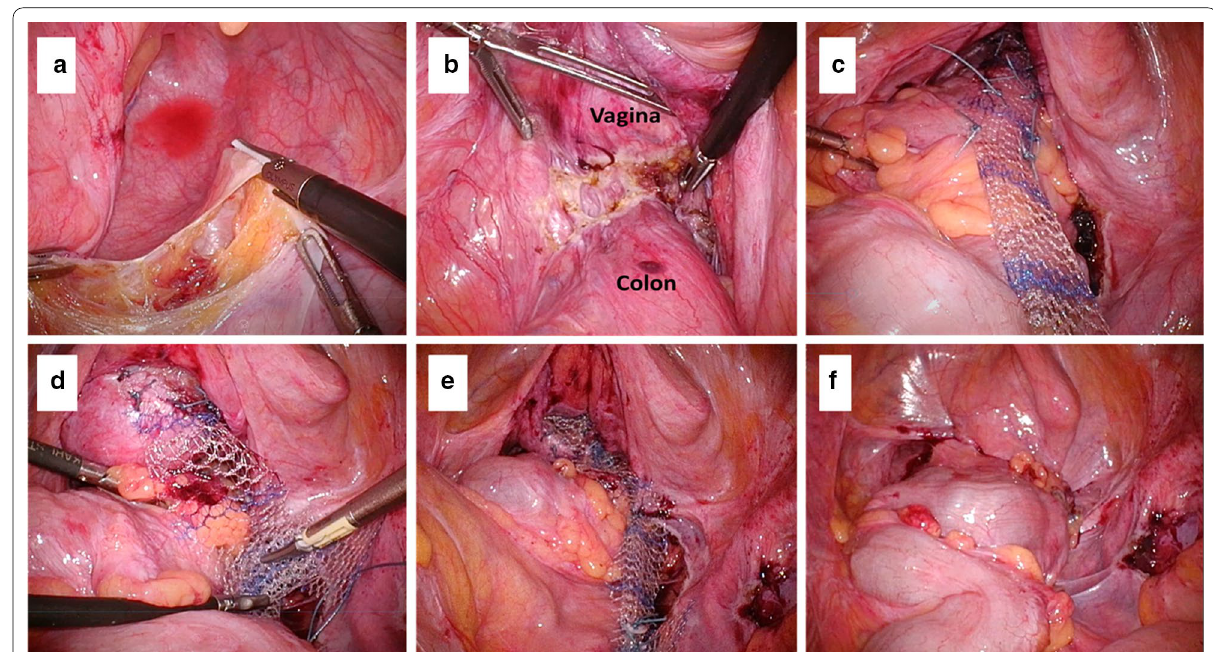
Fig. 3 Intra-operative findings. a The peritoneum was dissected from the right pelvic wall. Scar and a suture on previous laparoscopic posterior mesh rectopexy were observed (arrow). b The rectovaginal space was destroyed in the previous surgery. c The self-cut mesh was fixed with non-absorbable suture on the large colon. d The self-cut mesh was fixed at the bottom of vesicovaginal space and the top of uterus. e The meshes were bridged between the fixed points and the sacral promontory. f The meshes were covered with the peritoneum